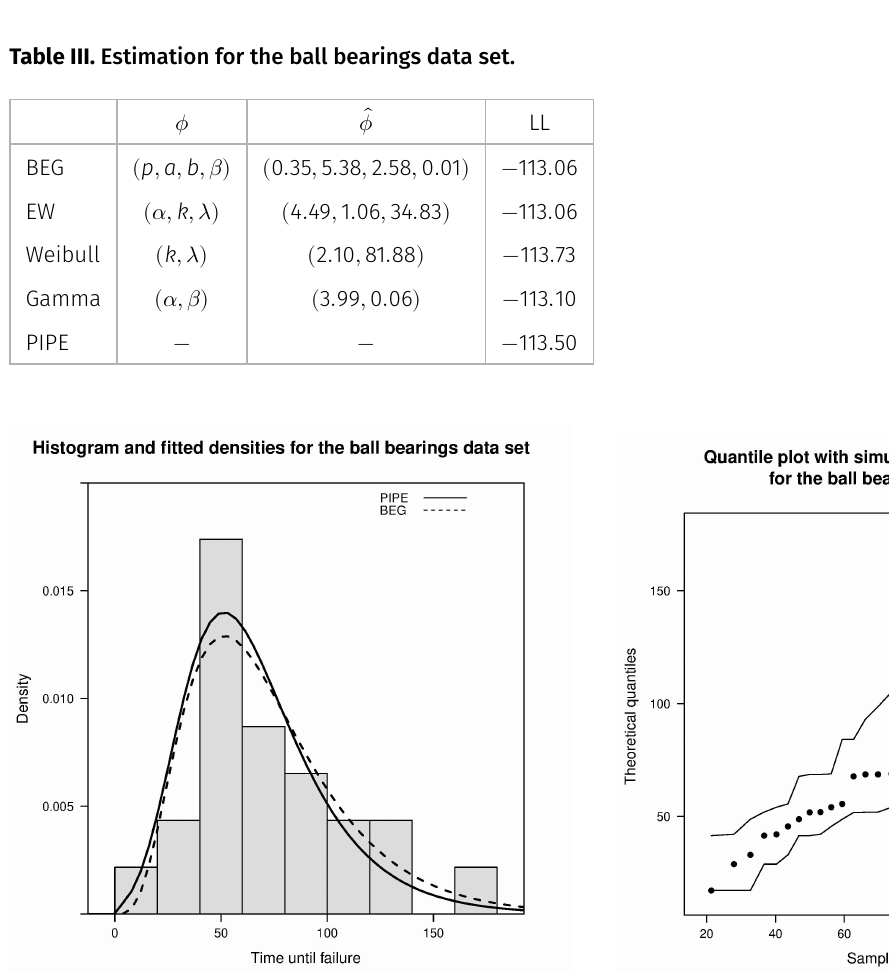
Figure 3. Histogram and quantile plot for the ball bearings data